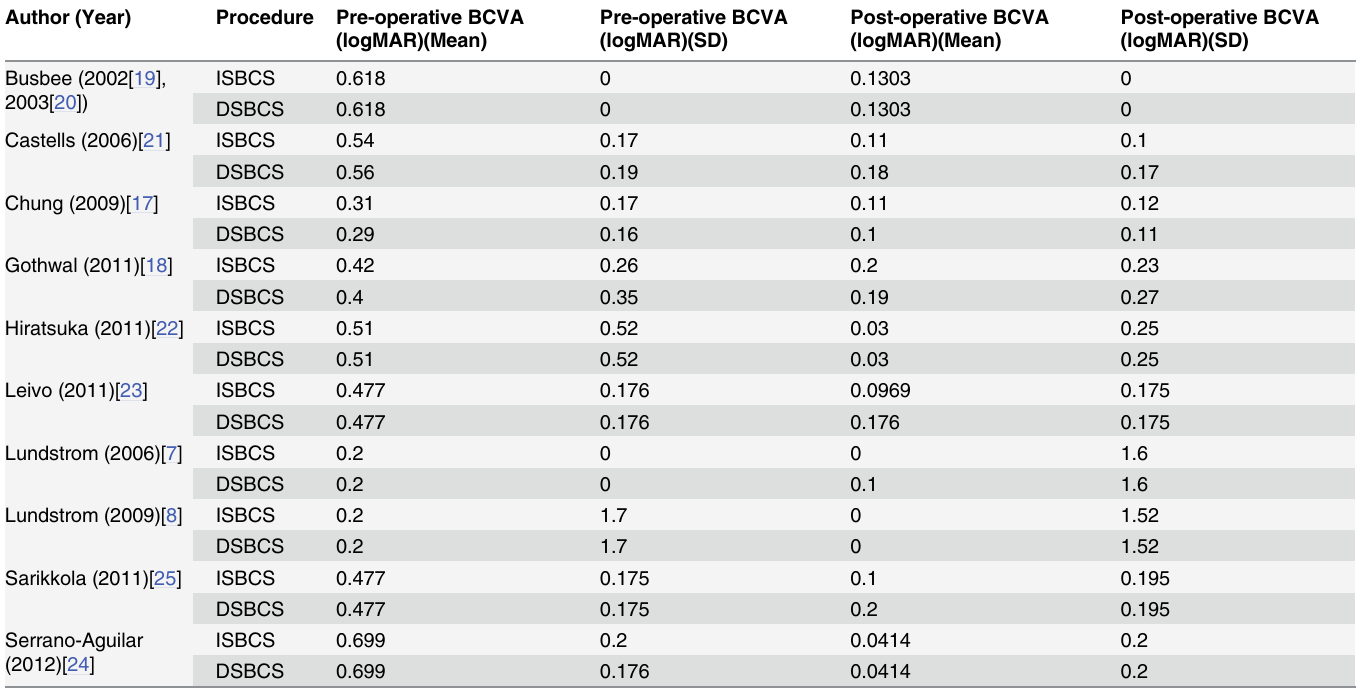
Table 3. Best Corrected Visual Acuity (BCVA) Reported in Studies Included in Meta-Analysis.